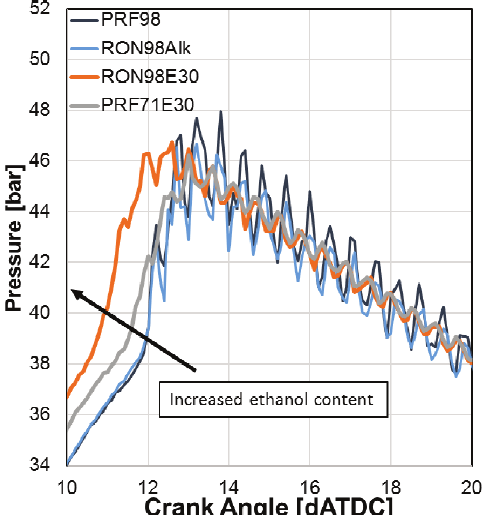
Fig. 8. Cylinder pressure from spark timing to combustion knock for each test fuel at RON rating conditions